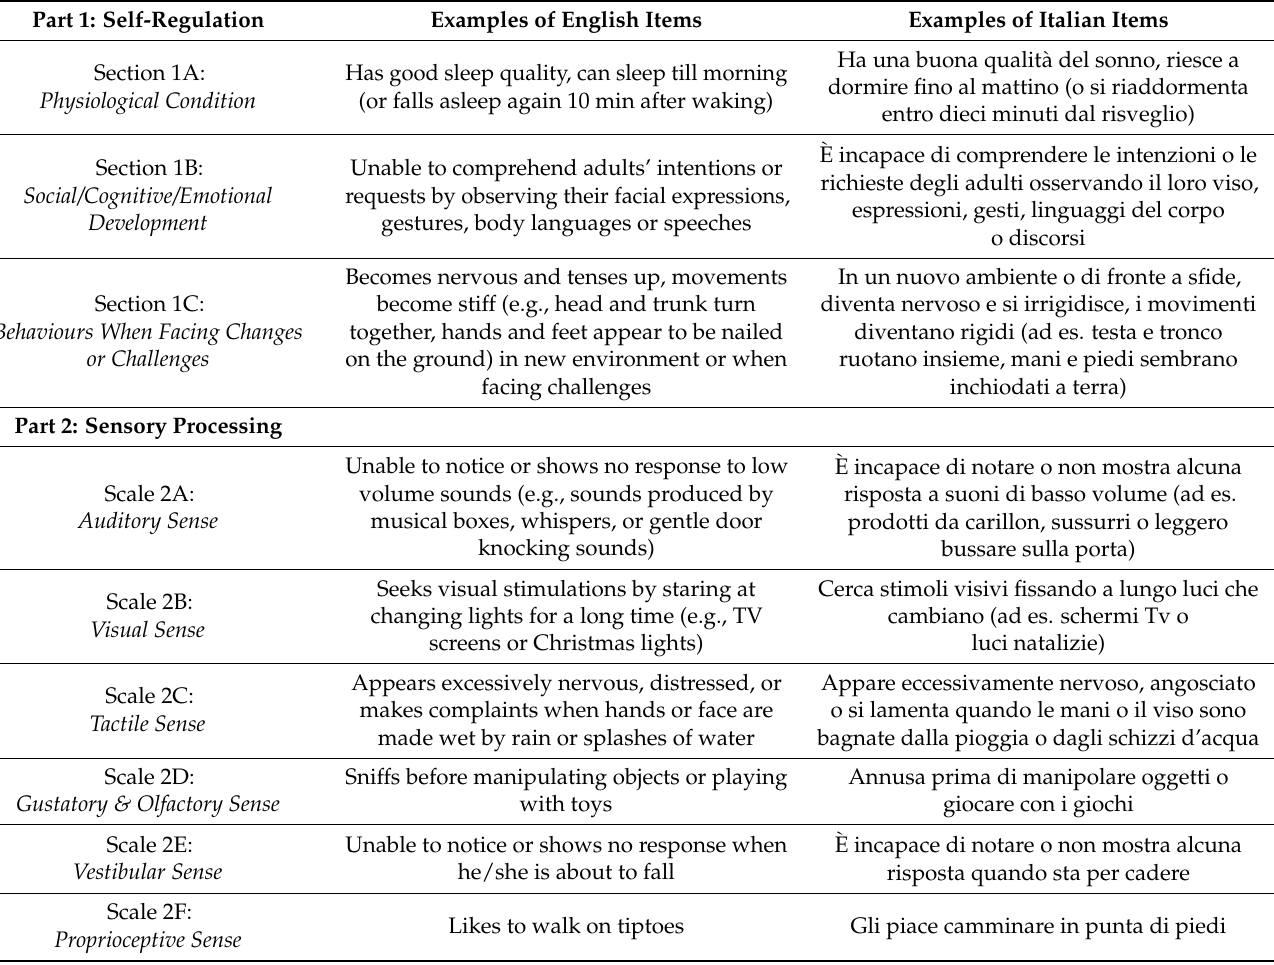
Table 1. Example of English items translated into Italian language. Examples of English Items Examples of Italian